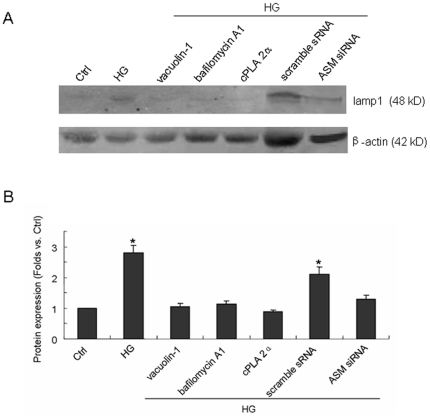
Effect of lysosomal inhibitors or ASM gene silencing on HG-induced increase of lamp1 protein quantity on cellular membrane.The proteins on cellular membrane were first isolated and then the lamp1 expression was detected by Western blot. A: representative band of lamp1 expression in cell incubated by normal glucose (Ctrl) or high glucose for 12 h (HG) with or without the pretreatment by vacuolin-1(10 µmol/l), bafilomycin A1 (100 nmol/l), cPLA 2α (20 µmol/l) for 1 h, or after scramble sRNA or ASM siRNA transfection. B: summarized data of lamp 1 protein quantity normalized by β-actin in different groups. Values are means±SE; n = 4 batches of cells. * P<0.05 vs. Ctrl.